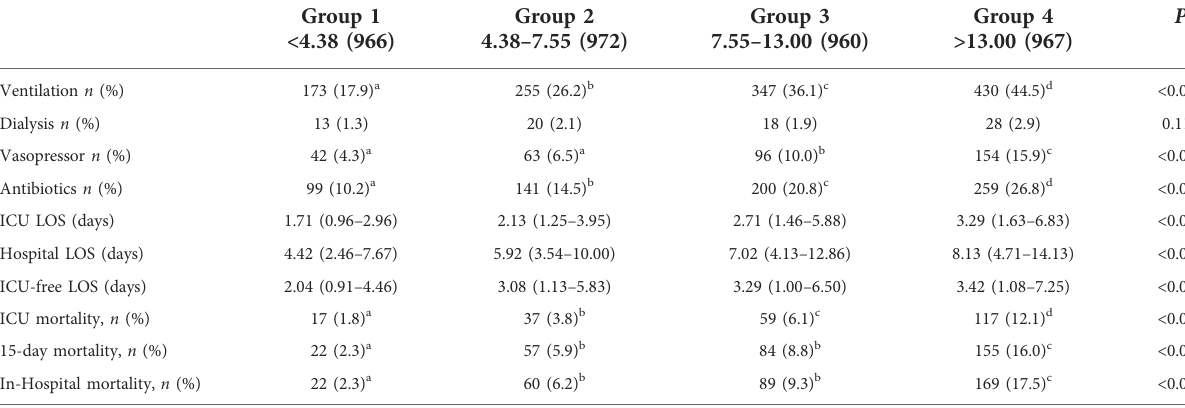
TABLE 2 Univariate analysis of clinical outcomes in 3,865 patients by NLR